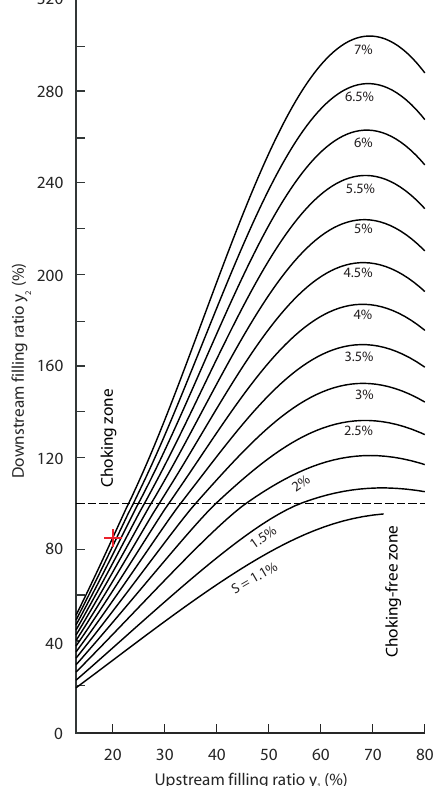
Figure 9. Filling ratio at the sequent depth section of direct hydraulic jumps in a circular pipe with a slope S = 1.1% to